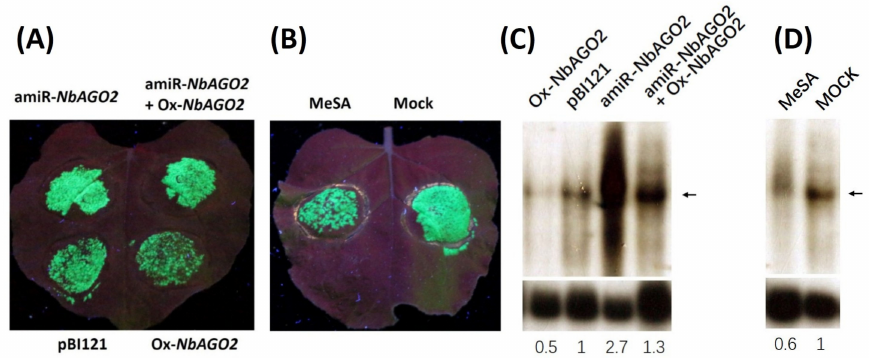
Figure 6. NbAGO2 contributed to TMV defense in N. benthamiana . ( A ) N. benthamiana plants were first inoculated with di ff erent combinations of vector constructs by agroinfiltration, and infected with TMV-GFP after one day of inoculation. GFP fluorescence was visualized by hand-held UV lamp at 320 nm, and the photographs were taken five days post TMV infection. pBI121, empty pBI121 vector; amiR- NbAGO2 , amiR- NbAGO2 construct in pBI121 vector; Ox- NbAGO2 , NbAGO2 overexpression construct in pBI121. ( B ) N. benthamiana plants were sprayed with 500 µ M MeSA daily, and infected with TMV-GFP after the first spray. GFP fluorescence was visualized by hand-held UV lamp at 320 nm, and the photographs were taken five days post TMV infection. ( C , D ) Detection of TMV genomic RNA by Northern blot experiment. The same treated samples from above were subjected to detection of TMV RNA. Total RNAs were isolated and TMV RNA level was determined by Northern blot experiment using capsid protein sequence specific probe labelled with 32 P. NbActin served as internal control and the mRNA level of NbActin was evaluated in the same way using 32 P labelled NbActin specific probe (lower panel). The band corresponding to TMV genomic DNA was indicated by the arrowhead. The number below the panel indicates the ratio of the blot band intensity between TMV and NbActin , in which the ratio in control lane was arbitrarily designated as